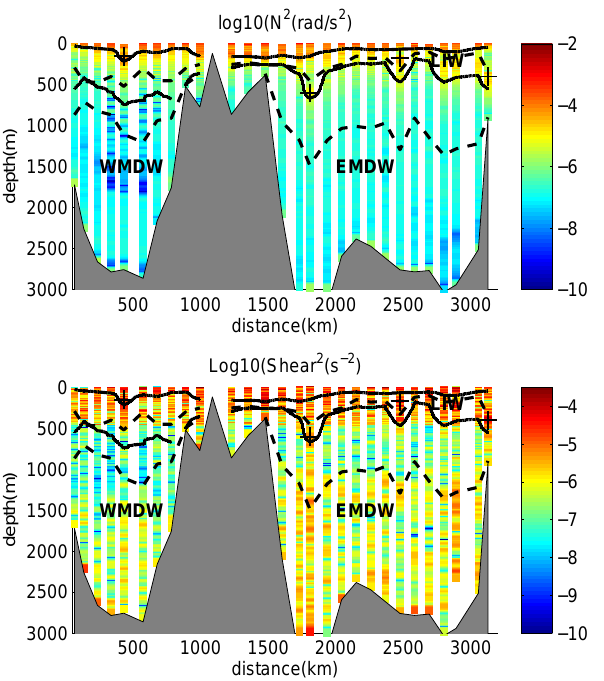
Fig. 13. Buoyancy frequency squared ( N 2 ) (upper panel), shear Figure 13: Buoyancy frequency squared ( N 2 )(upper panel), shear squared computed from 10m squared computed from 10m difference (lower panel) along the di(cid:27)erence (lower panel) along the BOUM transect. The abscissae x is expressed as the distance BOUM transect. The abscissae x is expressed as the distance along along the transect from the (cid:28)st station in the Rhone river mouth (not represented). Black cross indicate approximate positions of the base of eddy A, B, C and Ierapetra eddy. Black lines the transect from the first station in the Rhone river mouth (not rep- represent isopycnal 28.5 and 29.1 kg/m − 3 , black dashed lines represent the core of the LIW, and resented). Black cross indicate approximate positions of the base of the limits of EDMW and WDMW eddy A, B, C and Ierapetra eddy. Black lines represent isopycnal 28.5 and 29.1kgm − 3 , black dashed lines represent the core of the LIW, and the limits of EDMW and WDMW.